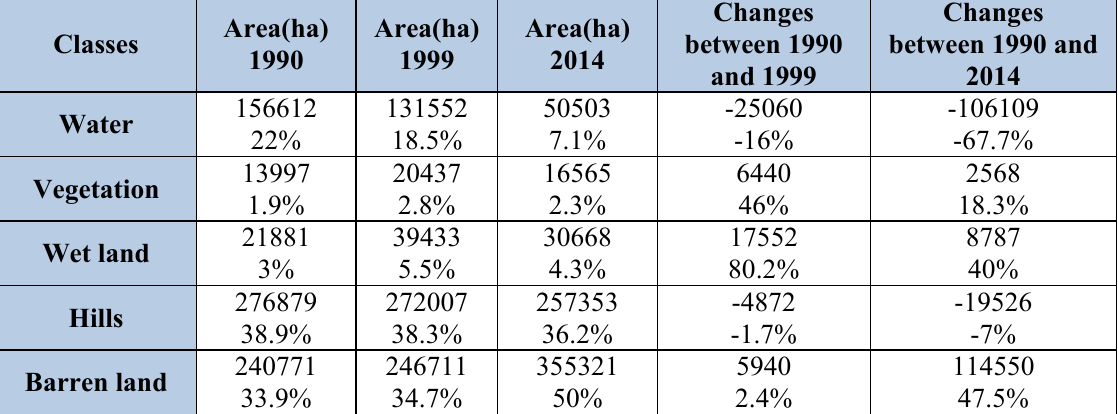
Fig.16: Supervised classification using Maximum Likelihood classifier method for Landsat-8 (2014). Table 4: The change in the years 1999, 2014 comparing with 1990 using Maximum Likelihood classifier